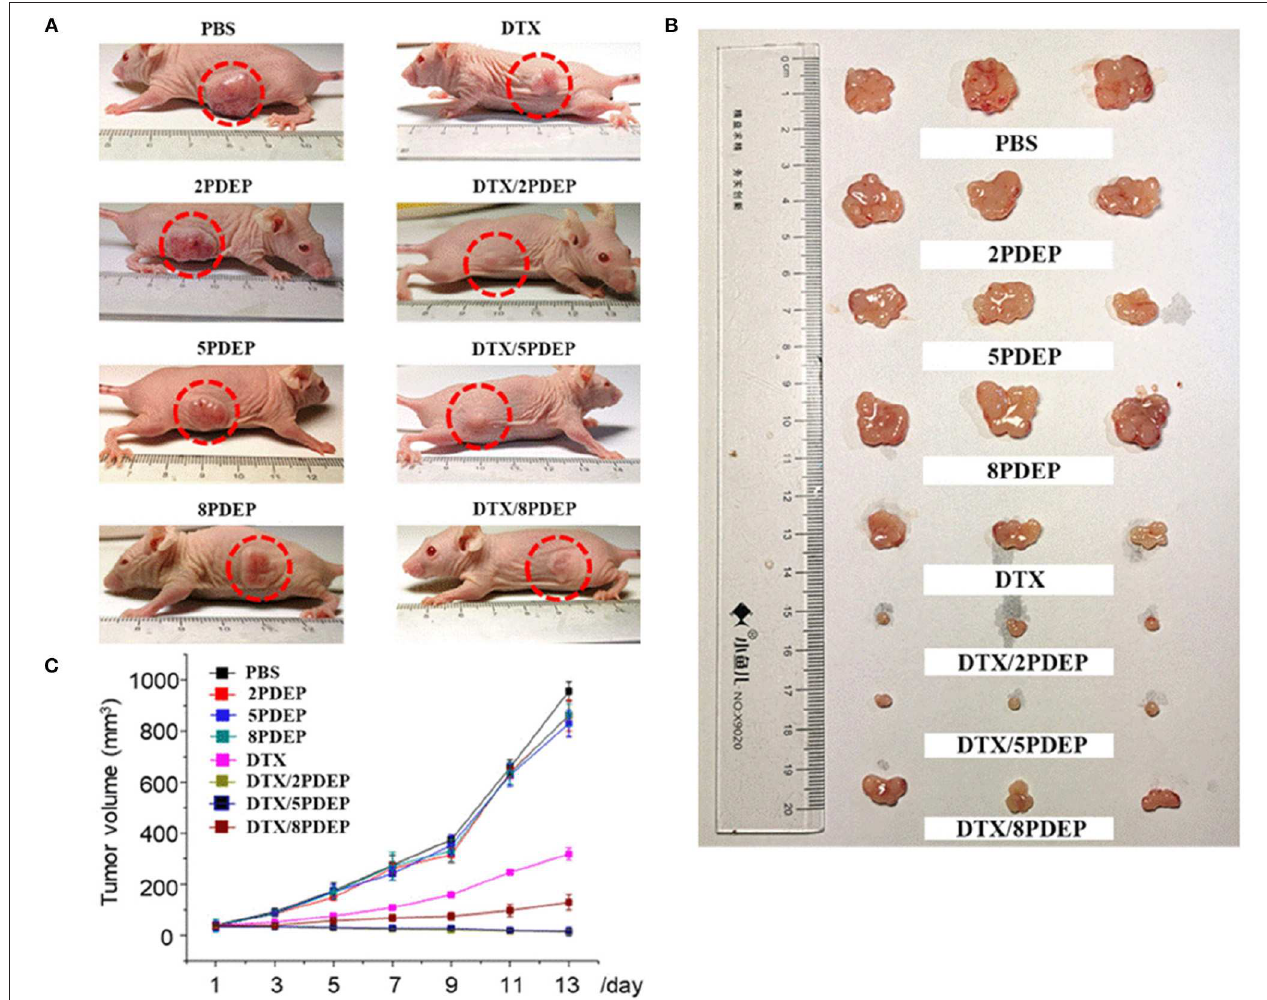
FIGURE 8 | The therapeutic effect of the DTX-loaded micelle-PDEP thermogel system on xenograft tumor mice established with HepG2 cells. (A) Tumor in the body of mice. (B) Tumor isolated from mouse. (C) Tumor volume size curve.